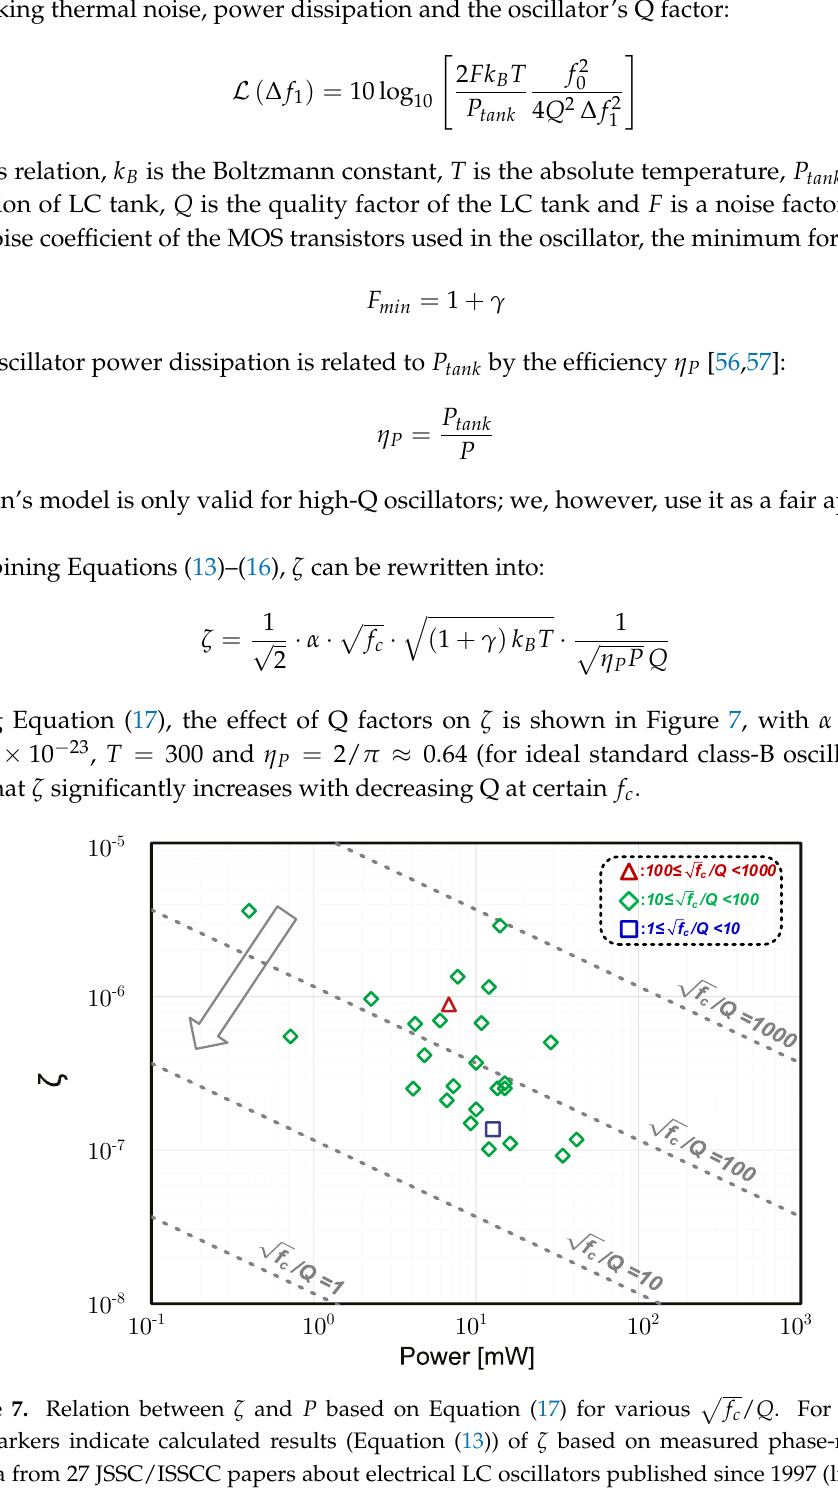
Figure 7. Relation between ζ and P based on Equation (17) for various the markers indicate calculated results (Equation (13)) of ζ based on measured phase-noise and f c data from 27 JSSC/ISSCC papers about electrical LC oscillators published since 1997 (link: https: